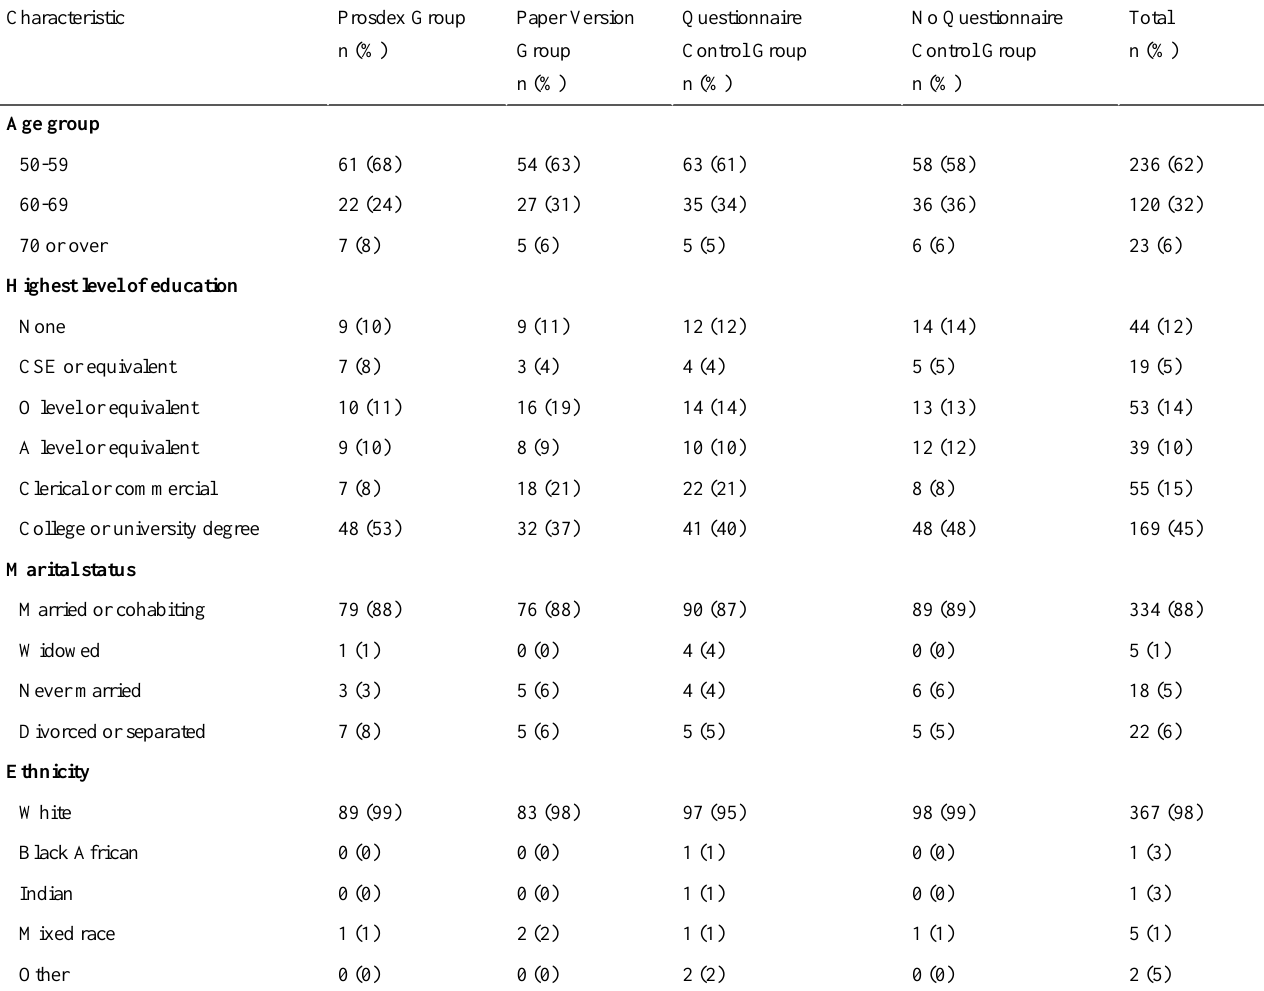
Table 1. Characteristics of trial participants